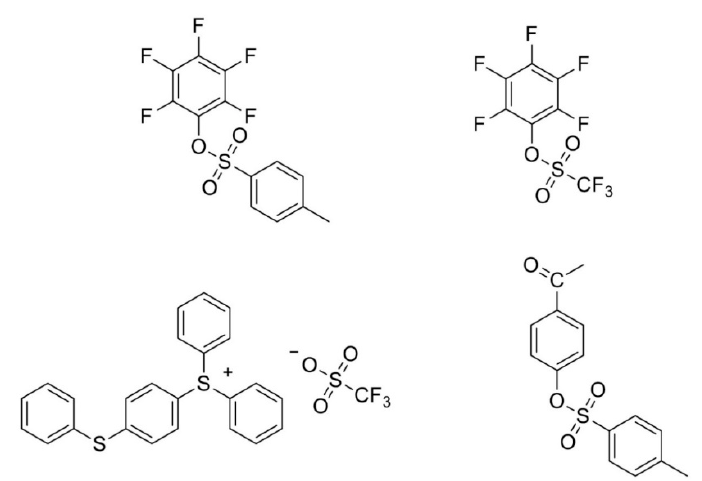
Figure 4. Fluorinated PAGs especially designed for EUV ( upper row ) and traditional PAGs ( lower row ) that were used for comparison in epoxy-based resist formulations. Adapted from [43], with permission from John Wiley & Sons, 2020.